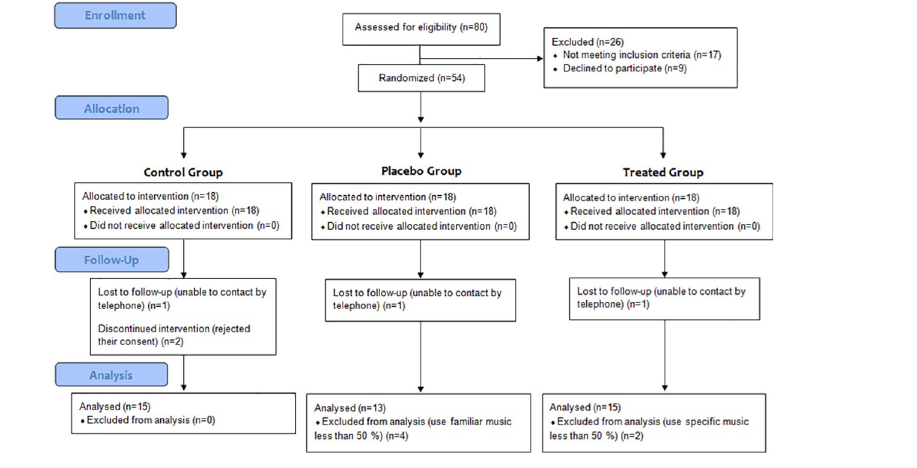
Fig 1. Flow diagram of the clinical trial.